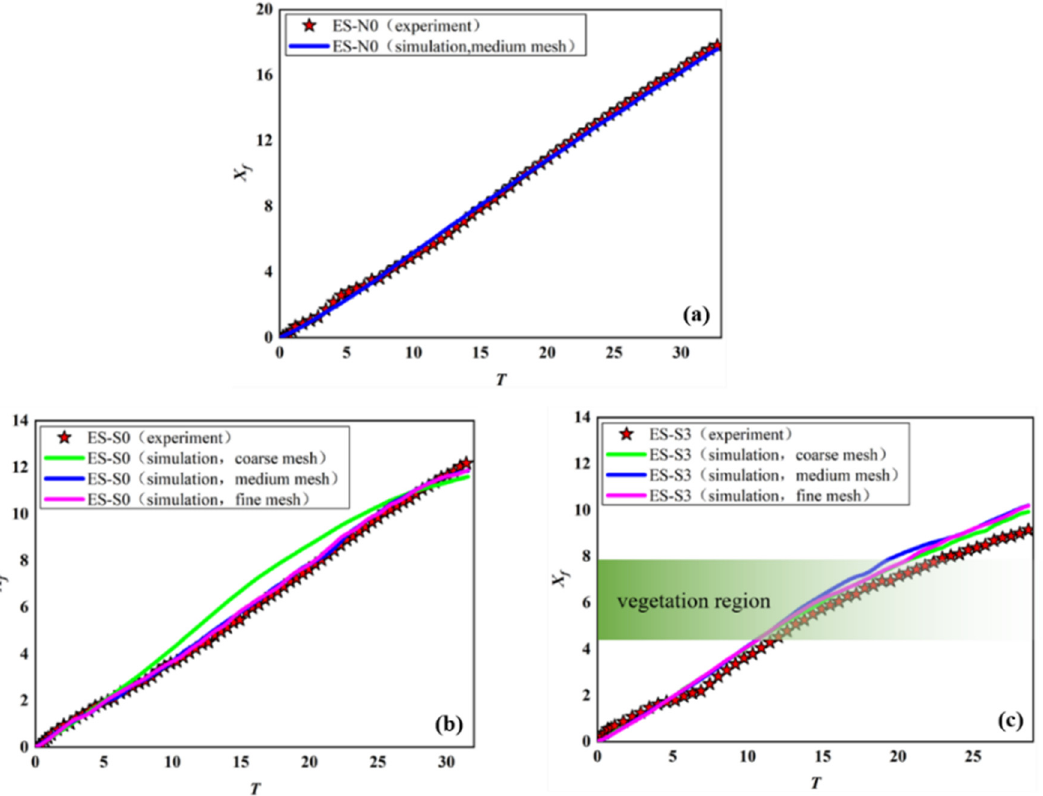
Figure 3. Comparisons between simulations with different mesh levels and the corresponding experimental measurements. ( a ) ES-N0, ( b ) ES-S0, and ( c ) ES-S3 (green rectangle denotes the vegeta- tion region).